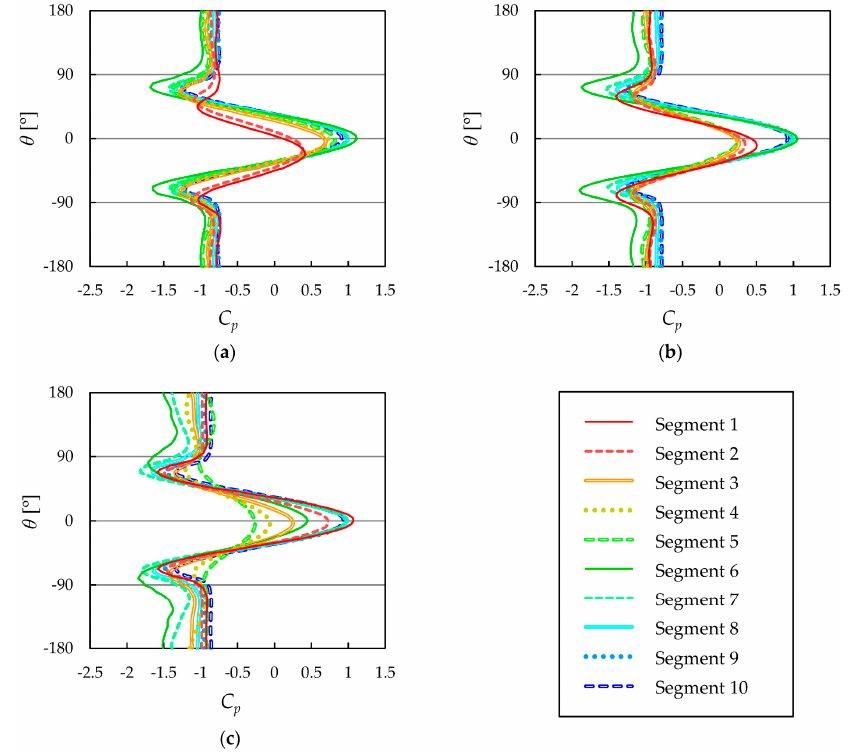
Figure 7. Distributions of the mean pressure coefficient on the tower surface at the mid-heights of each tower segment. ( a ) λ = 3; ( b ) λ = 6; and ( c ) λ = 10.